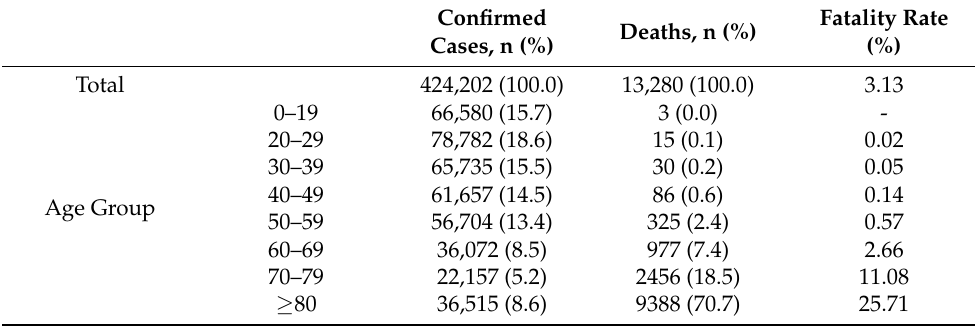
Table 2. Distribution of COVID-19 cases by age group in Canada (as of 15 December 2020). Of the 475,214 cases reported in Canada, age information was available for 424,202 cases.